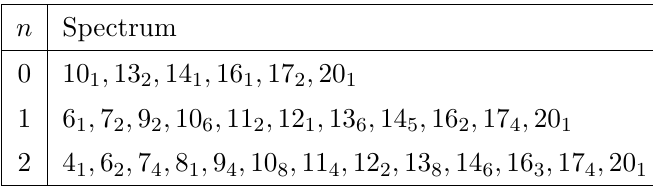
Table 2 . Energy levels of the su(4) model (2.1) with N = 4 spins in the subspaces (cid:6) (cid:6) ( n ) with n spins (cid:6) 1 = 2 and their corresponding degeneracies (indicated by